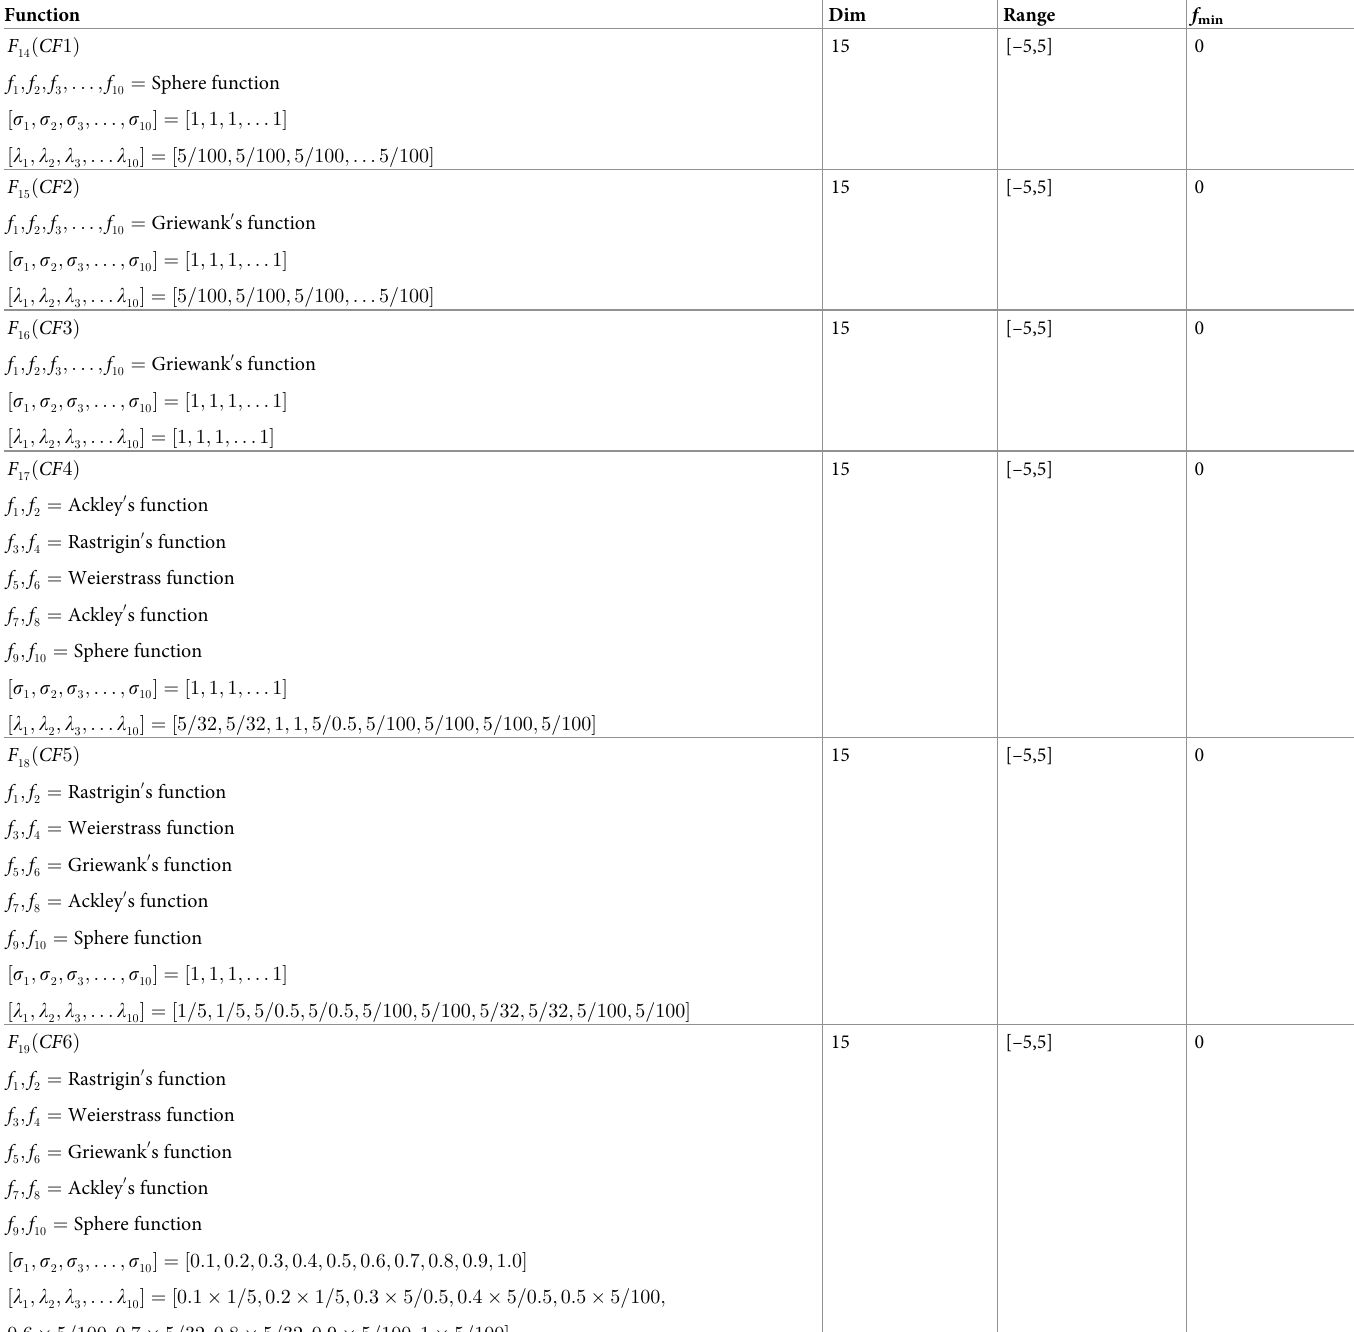
Table 5. Composite benchmark